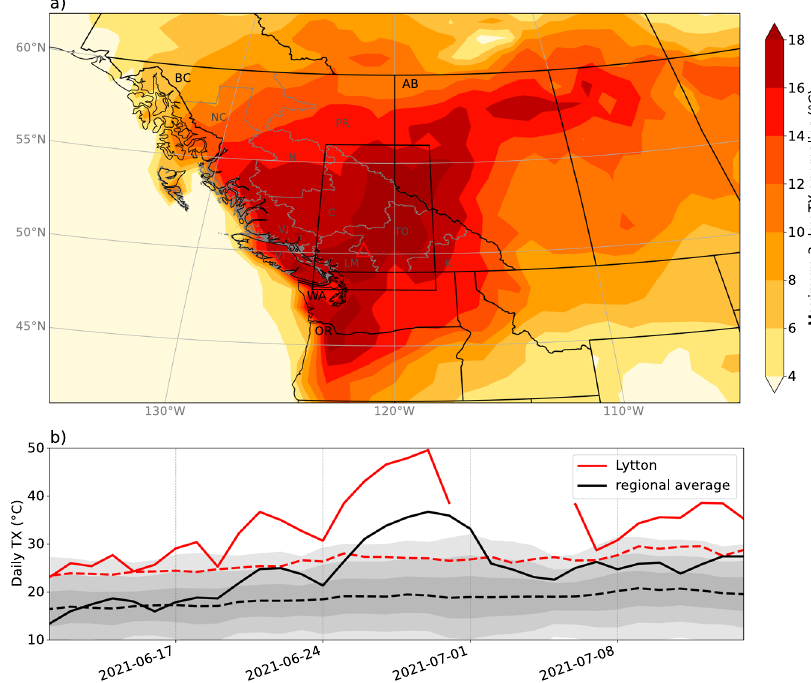
Fig. 1 | June 2021 Paci fi c Northwest heatwave temperatures. Heatwave daily maximum near-surface (2m) temperatures (TX). a ERA5 reanalysis data maximum 3-dayrunningmean(between23Juneand02July2021)ofTXanomaliesrelativeto adaily1981 – 2020climatology(seeMethodsformoredetails). b AbsoluteTXvalues for2021(solid)and1981 – 2020climatology(dashed);blacklines:spatialaverageof ERA5dataovertheblackboxin a ,withshading±1,2,and3standarddeviations;red